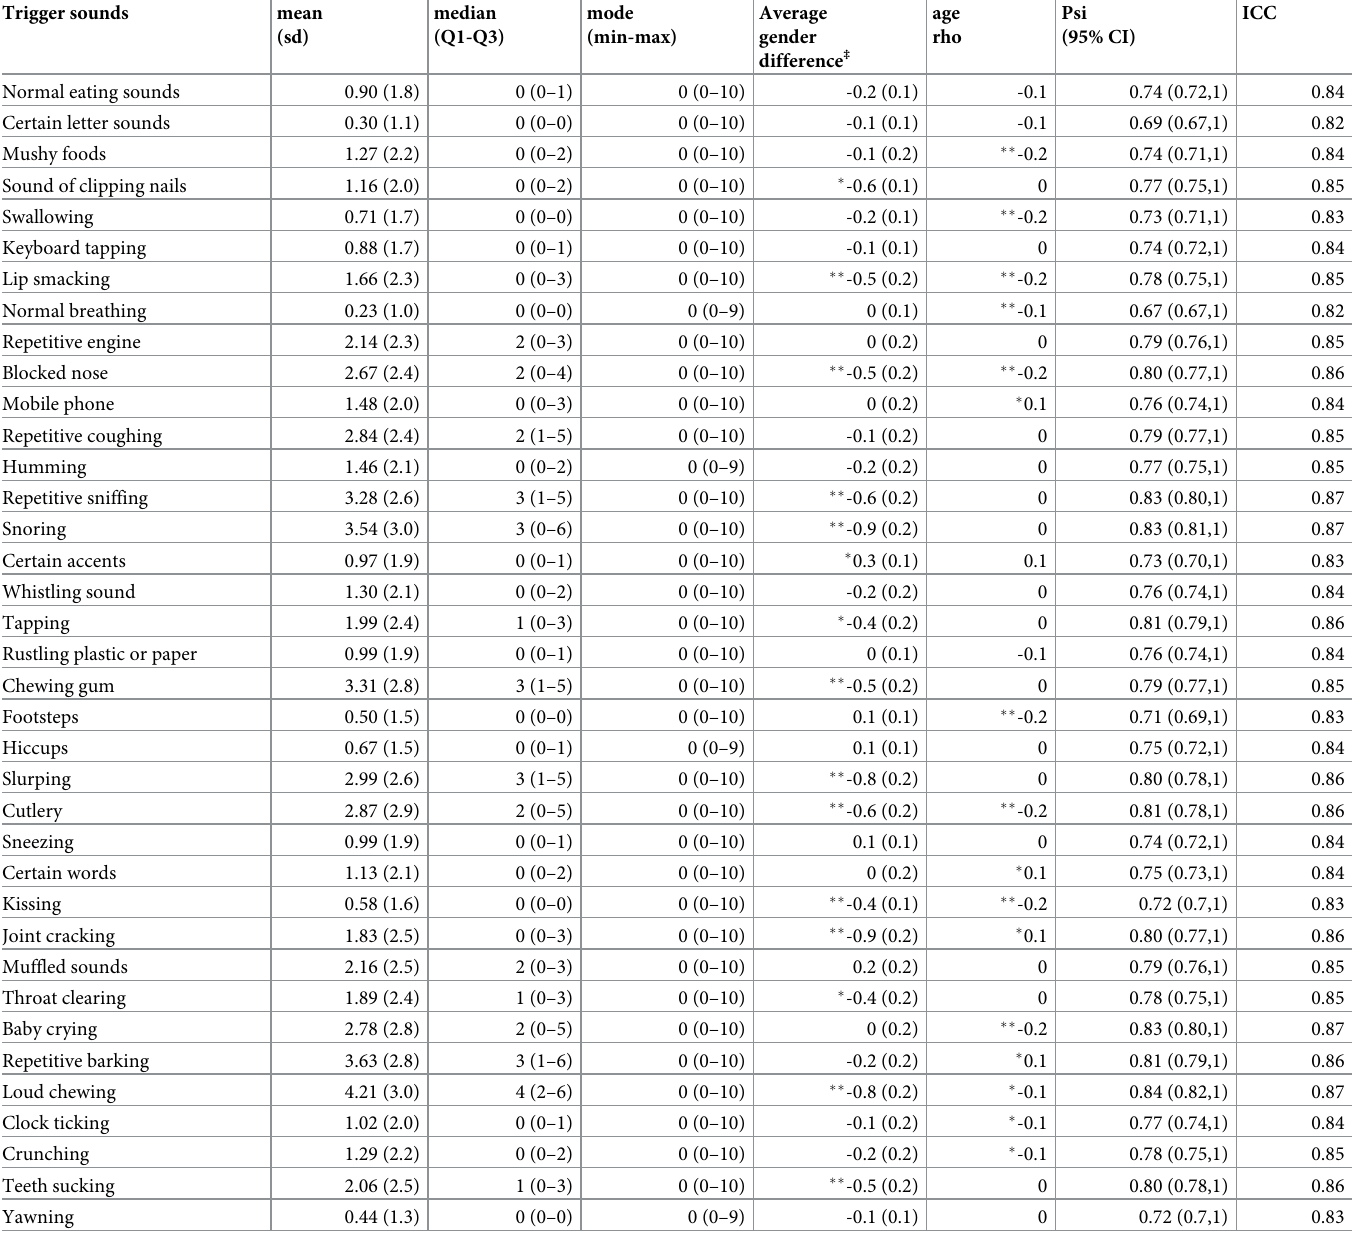
Table 6. Norms and reliability of the intensity items for the 37 S-Five-T